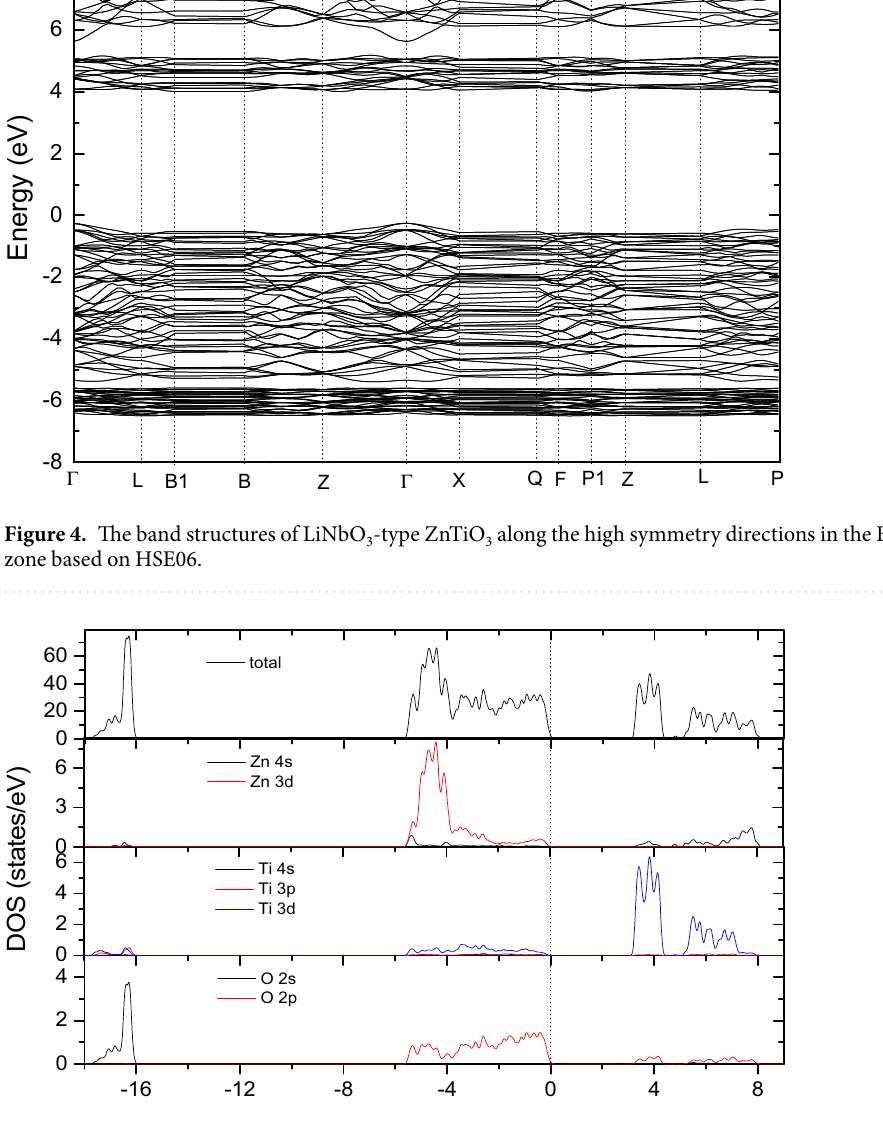
Figure 5. Total and partial density of states (DOSs) of LN-type ZnTiO 3 based on norm-conserving pseudopotentials within GGA with the Fermi levels at 0